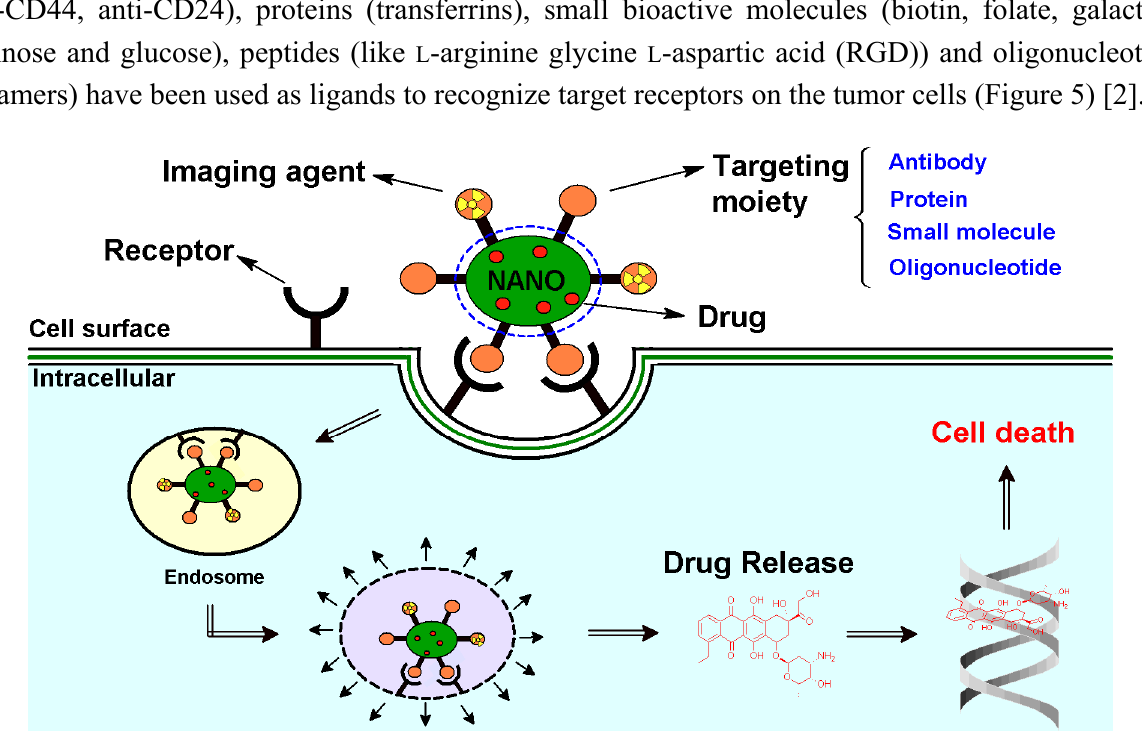
Figure 5. Schematic diagram representing the mode of action of targeted multifunctional nanoparticle (NP). The NP encapsulating a chemotherapy drug is targeted to the cancer cell surface by the cancer cell-specific ligand. The NP then binds to the cancer cell surface by recognizing the receptor, resulting in internalization of the NP by endocytosis. Inside the cancer cell, the NP undergoes endosomal escape, leading to the release of the treatment cytotoxic drug, which then activates consecutive steps, resulting in cell death. Anti-HER2 targeting antibodies conjugated to liposome-grafted PEG chains strongly increased the uptake of the NPs in HER2-expressing breast tumors. Liposomes without the anti-HER2 antibody were concentrated in the perivascular and stromal spaces and were internalized by the cancer-associated macrophages, reducing the availability to the tumors [40]. The transferrin receptor, which is overexpressed prostate cancer preclinical model, transferrin-conjugated PLGA NPs with encapsulated